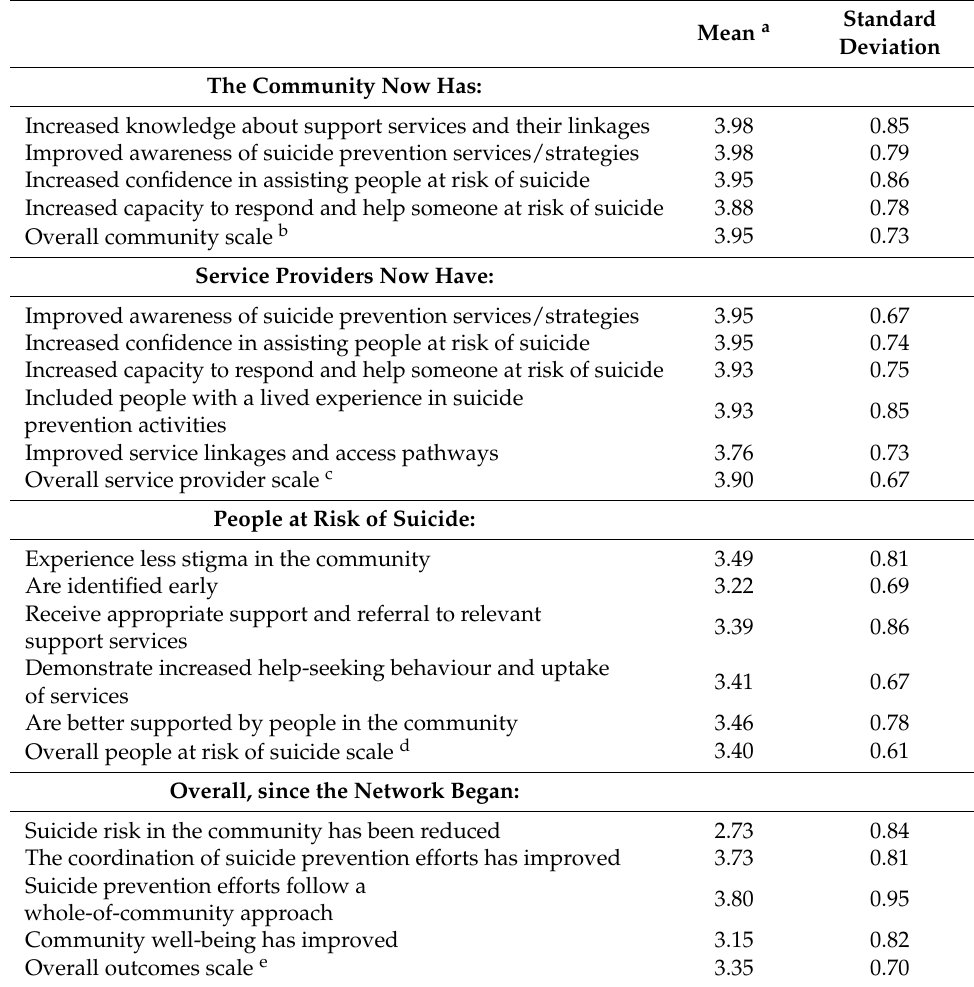
Table 4. Perceived community outcomes resulting from network activities ( N =